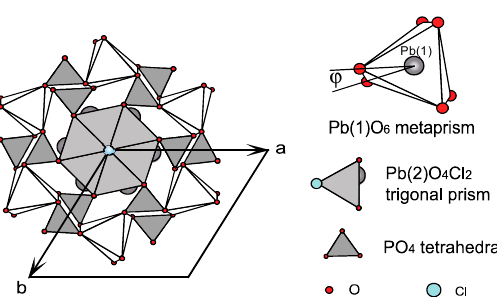
Figure 4. The pyromorphite structure projected along [0001], showing the PO 4 tetrahedra, the Pb(2)O 4 Cl 2 trigonal prism and the twist angle of Pb(1)O 6 metaprism.